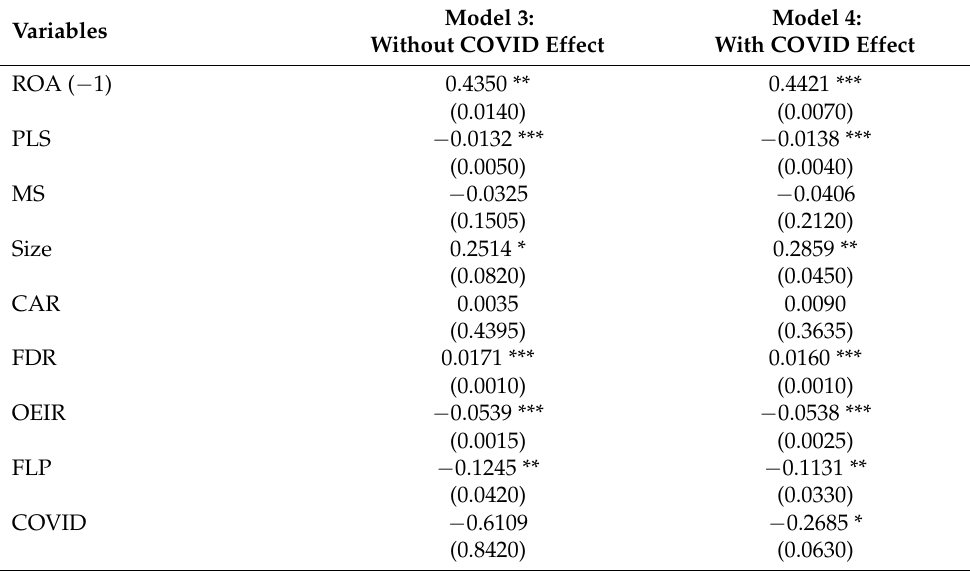
Table 5. ROA-PLS relationship: ratio of PLS financing to total